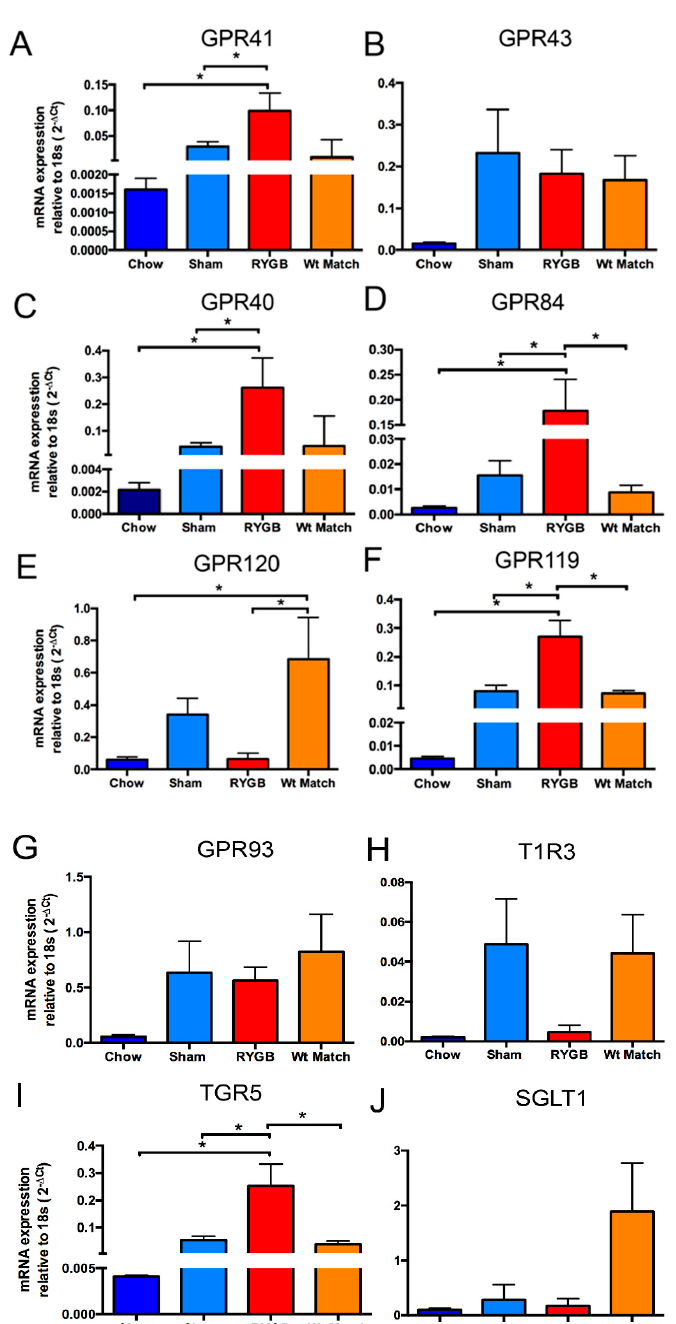
Figure 2. Altered colonic mRNA expression in obesity, Roux-en Y gastric bypass surgery (RYGB) of nutrient-sensing receptors for short-chain fatty acid receptors GPR41 and GPR43 ( A , B ), medium-chain fatty acid receptors GPR40, GPR84 and GPR120 ( C – E ), lipid amide sensor GPR119 ( F ), amino acid-sensing receptors GPR93 and T1R3 ( G , H ), bile acid sensor TGR5 ( I ), and sodium-glucose cotransporter SGLT1 ( J ). The expression is described relative to 18s and represents N = 5–7. Error bars show SEM, and significance is p < 0.05 as denoted by